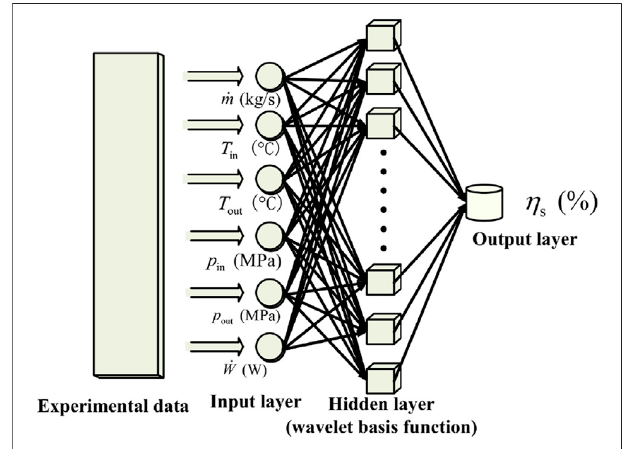
FIGURE 5 | Topological structure of the